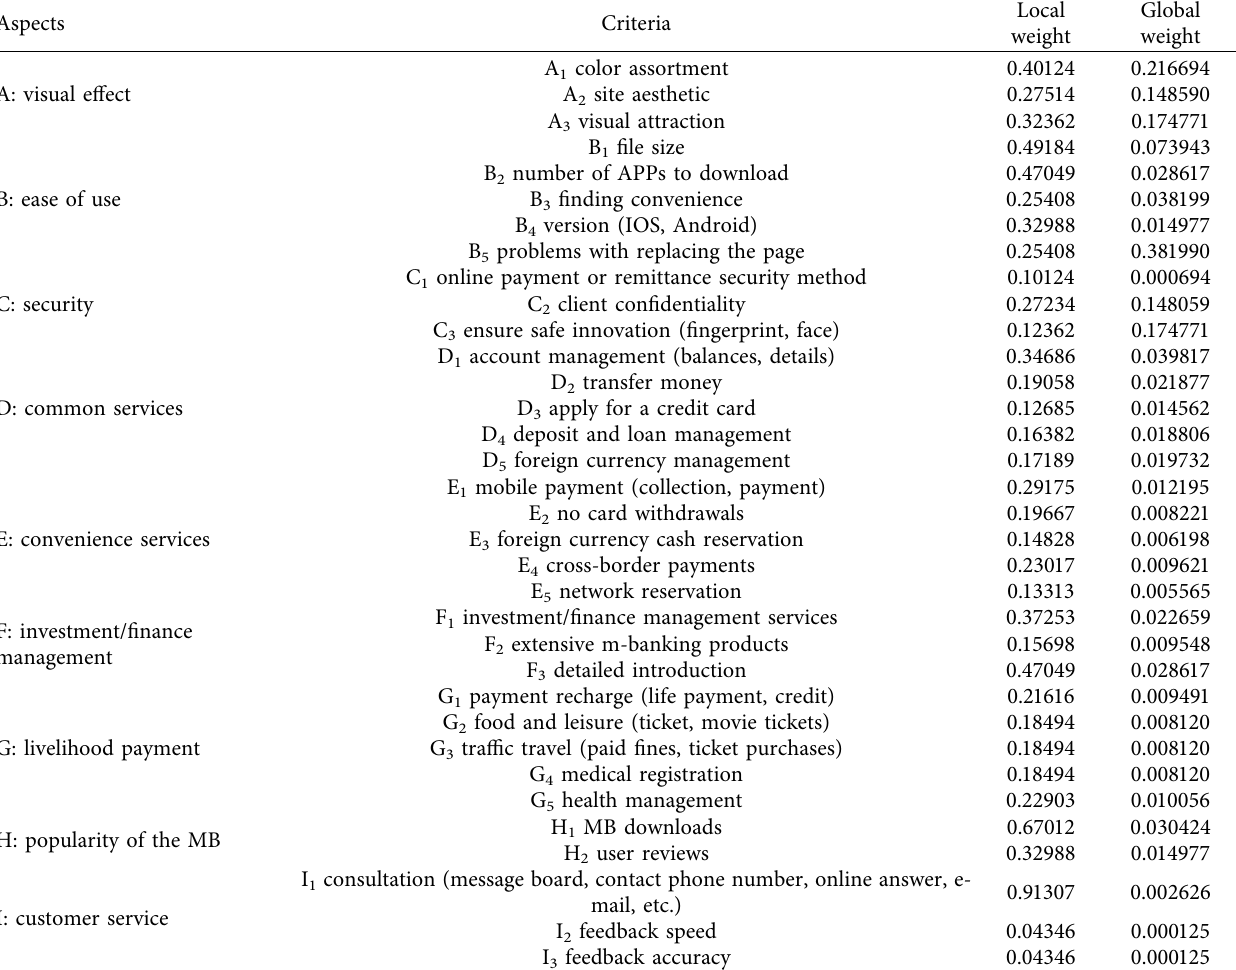
Table 21: Implementation of the stable weight